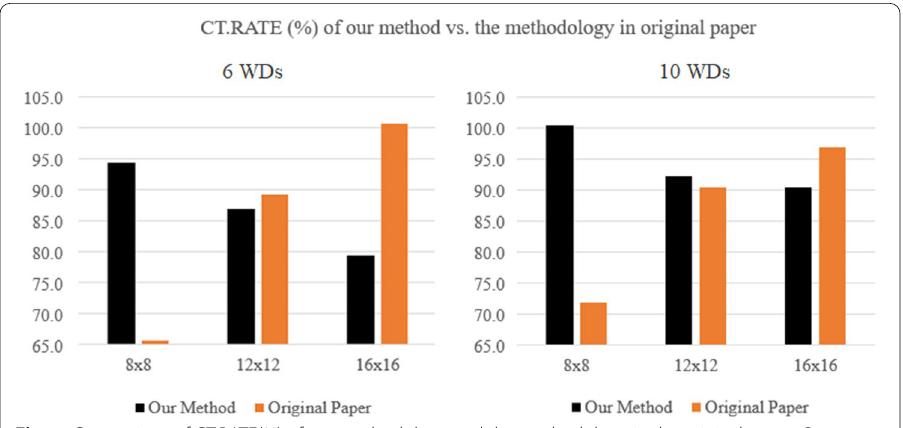
8 , but × 12 , and our methodology shows worse ×